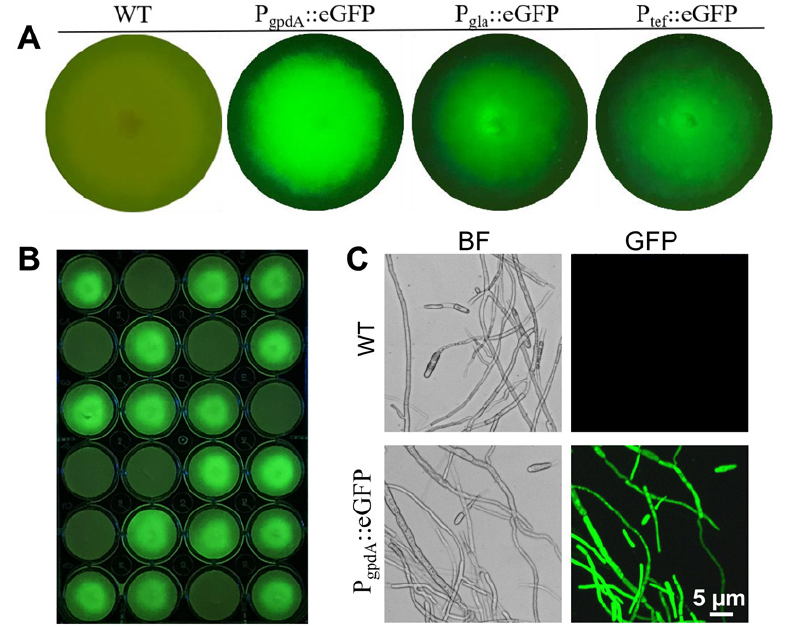
Figure 4. Screening of endogenous promoters with strong expression activity in F. venenatum TB01. ( A ) Representative images of fluorescent colonies. The eGFP reporter gene in F. venenatum TB01 was driven by endogenous promoters of gpdA (glyceraldehyde-3-phosphate dehydrogenase gene), gla (glucoamylase gene), and tef (translation elongation factor gene). ( B ) Fluorescence image acquisition of PgpdA::eGFP -expressing colonies on a 24-well plate using a hand-held lamp. ( C ) Representative images of PgpdA::eGFP expression in hyphae and conidia.